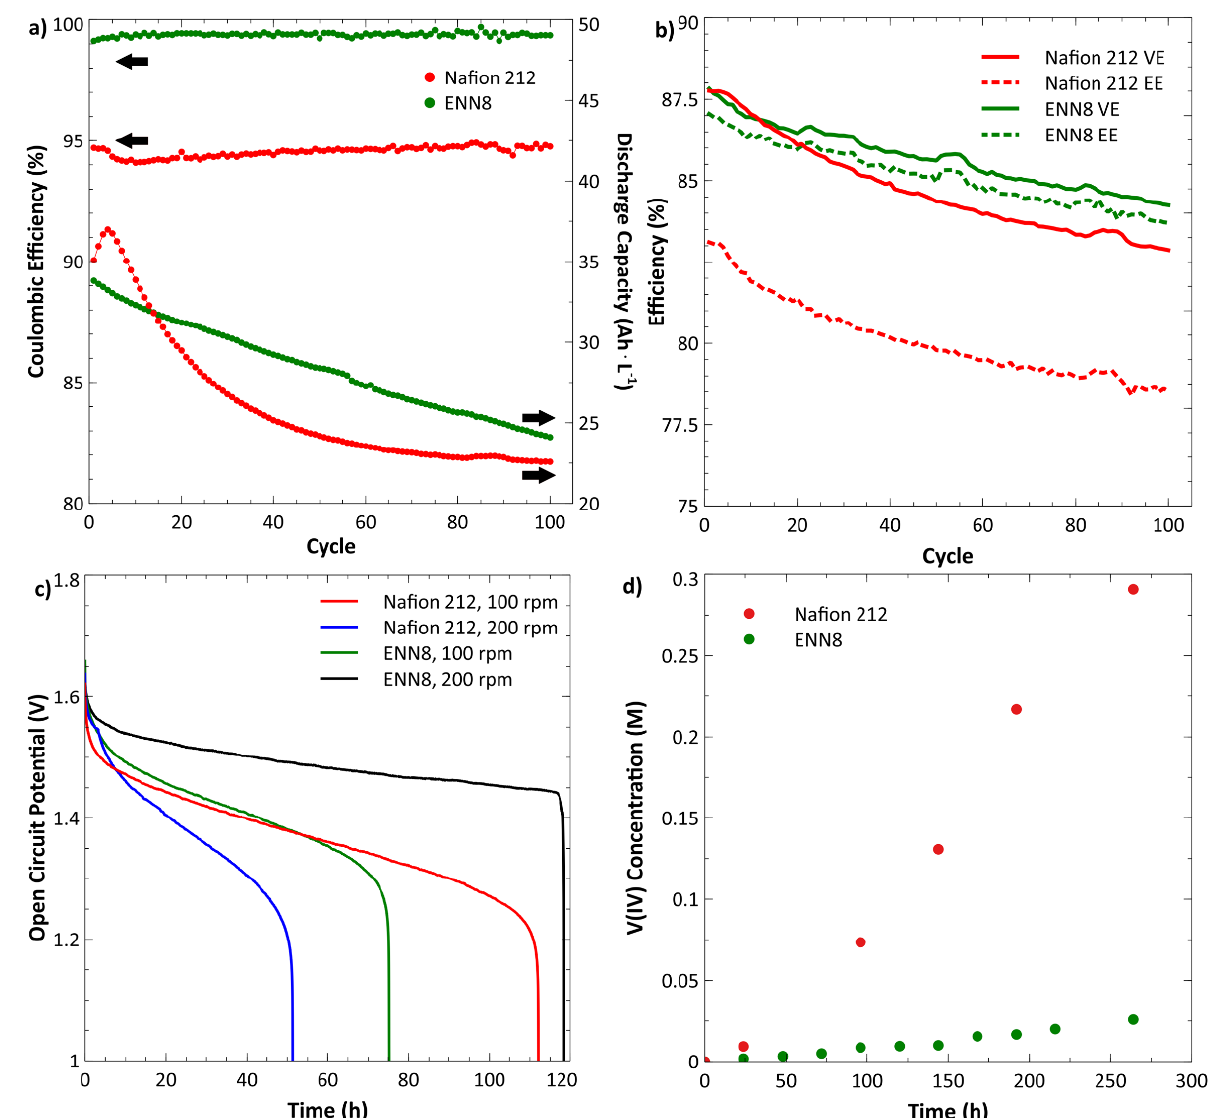
Figure 4. ( a ) CE and Discharge Capacity over 100 cycles of the VRFB cell with Nafion 212 and ENN8 membranes, ( b ) VE and EE comparison of Nafion 212 and ENN8, ( c ) Open-circuit voltage measurements for Nafion 212 and ENN8 over time at 100 and 200 rpm, ( d ) Diffusion measurements of Nafion 212 and ENN8. Experimental conditions: 1.6 M V(III) negative electrolyte, 1.6 M V(IV) positive electrolyte, both in 2M H 2 SO 4 supporting electrolyte, constant current charging at 200 mA cm − 2 and room temperature.